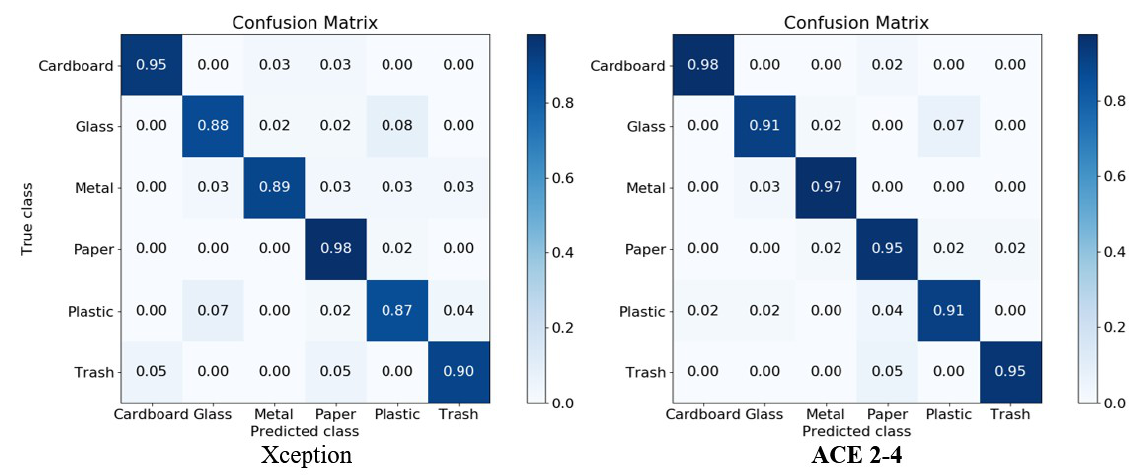
Figure 9. Confusion matrix of the original Xception and the final “ABE 2-4” with 2 linear blocks followed by a dual-attention module each, with 4 parallel branches in each